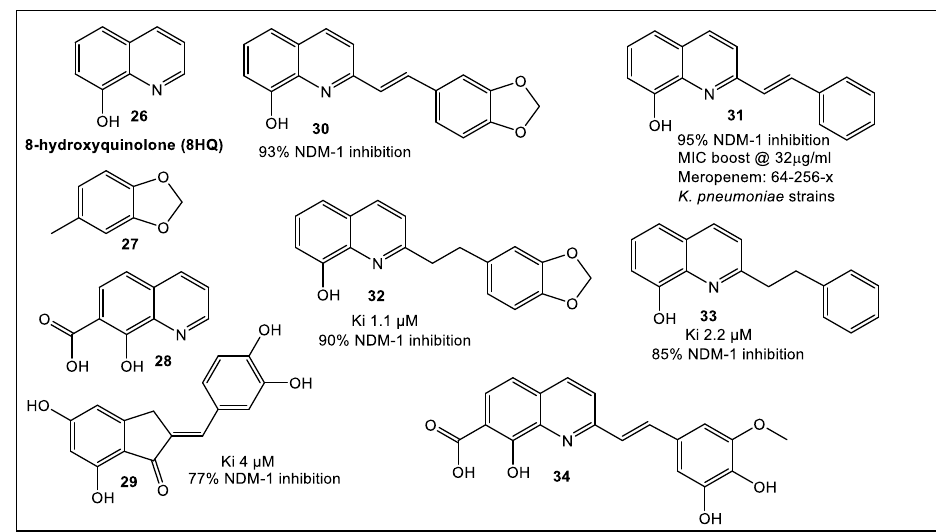
Figure 5. Fragment 26 synthetic analogs. Fragment 26 inhibition of NDM-1 was predicted by virtual